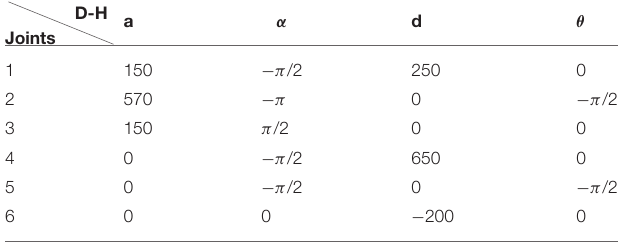
TABLE 1 | The link parameters in D-H model for the GOOGOL GRB3016 robot. D-H a Joints